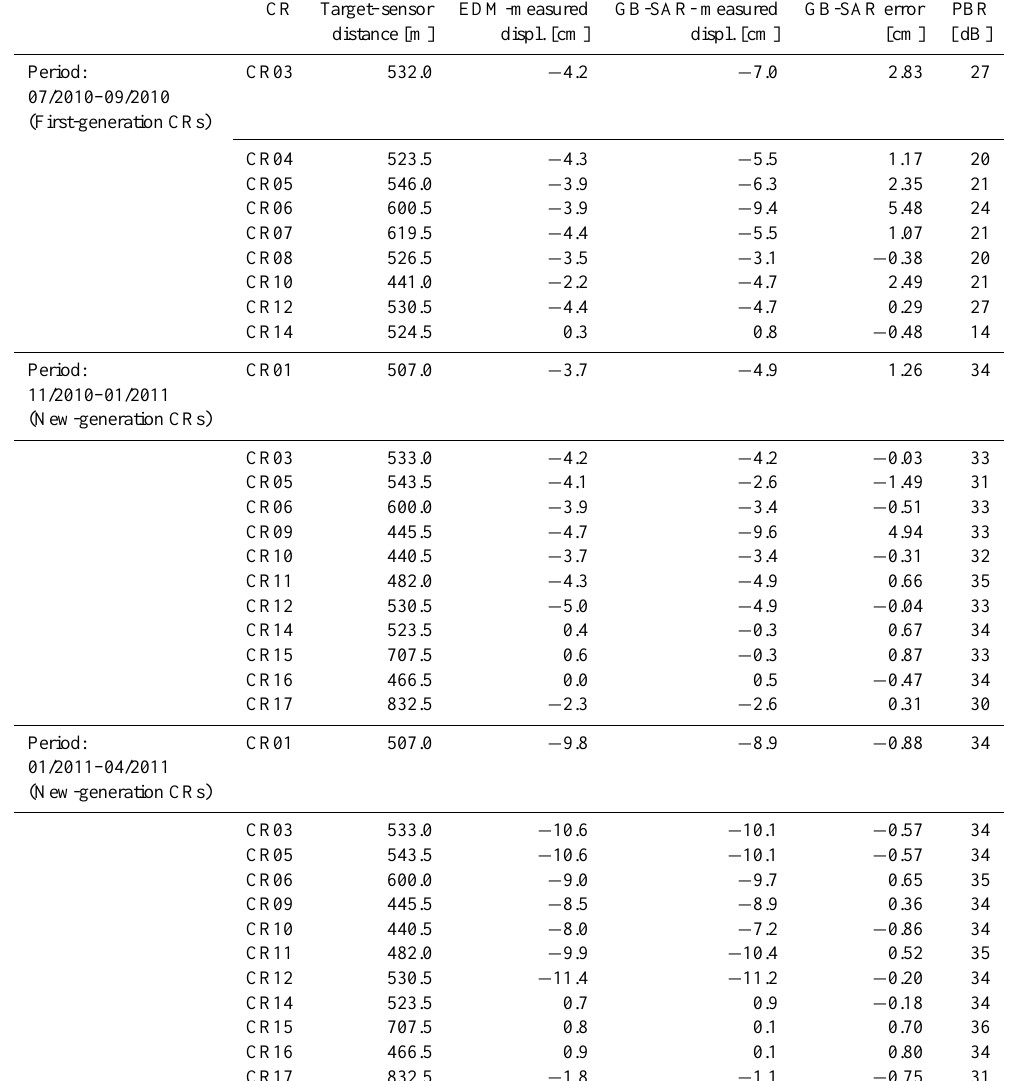
Table 2. GB-SAR results for three measurements on Vallcebre test site and their comparison with EDM results. CR